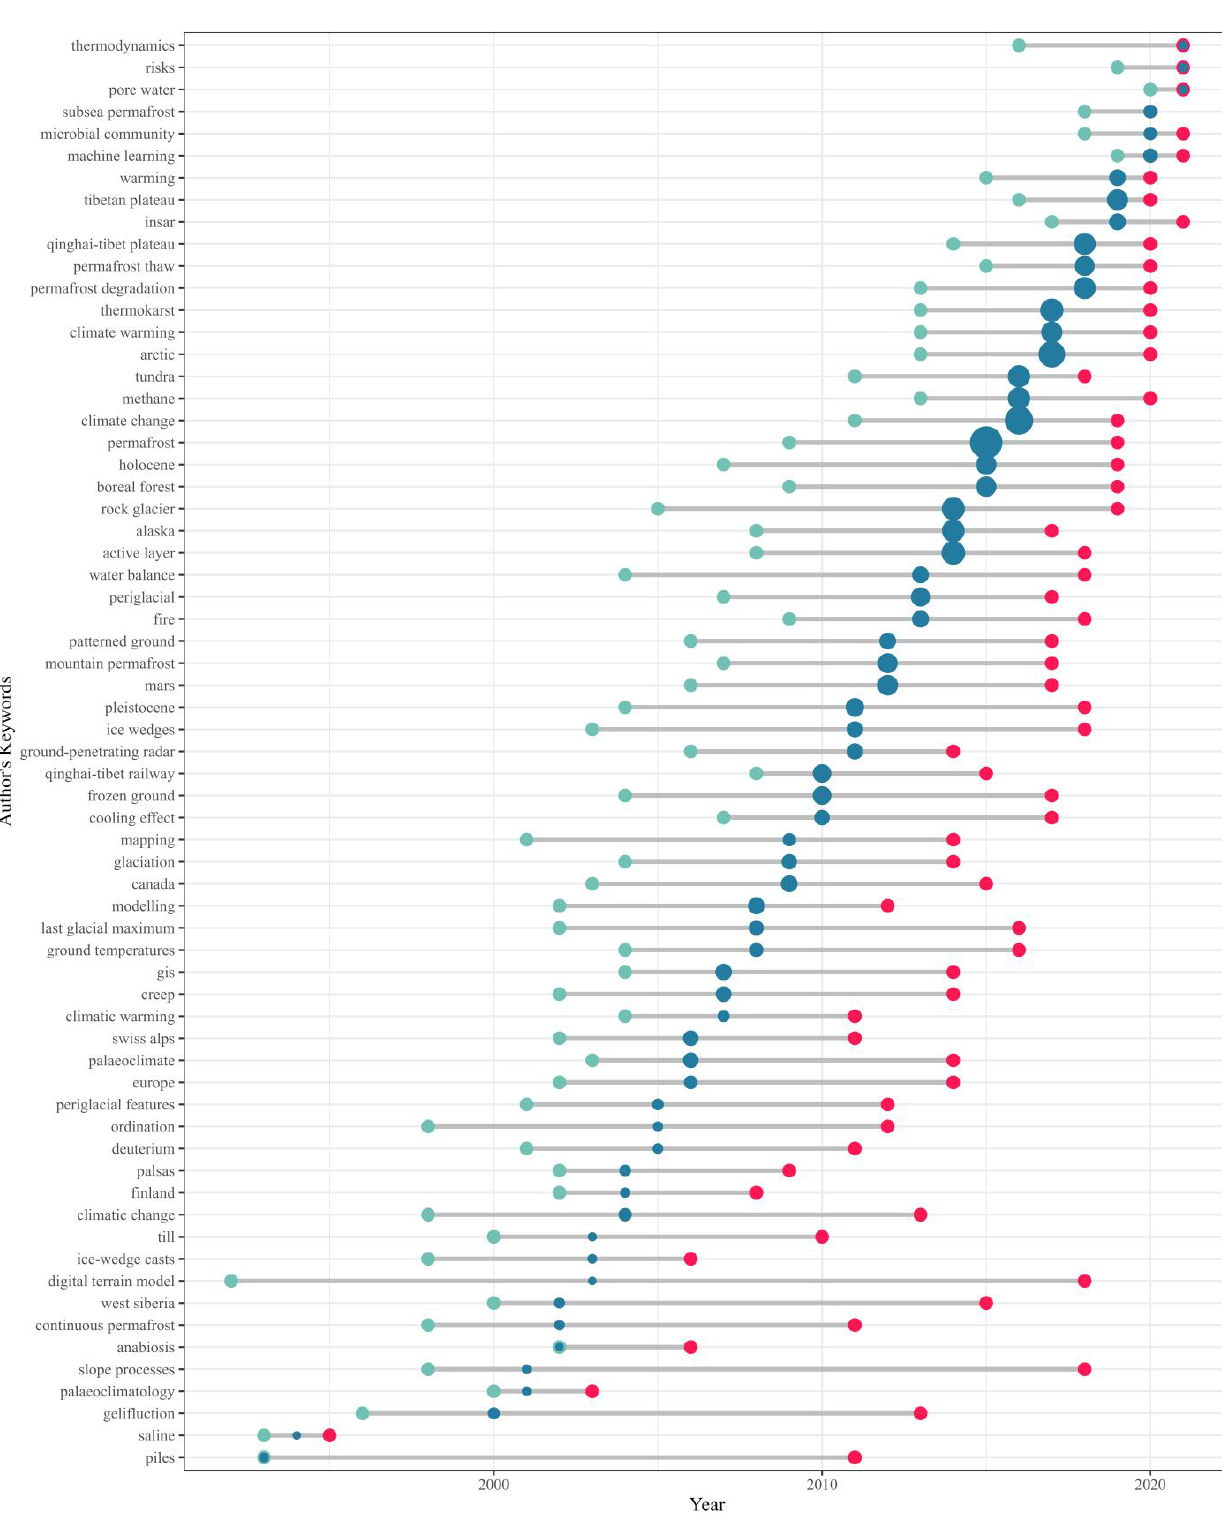
Figure 11. Temporal trends according to keywords. The x-axis presents the year, and the y-axis shows the keywords. The green dot, red dot, and blue dot indicate the first quartile, the third quartile, and the median year of the publications, respectively. The size of the blue dot reflects the number of papers; the bigger, the larger number.